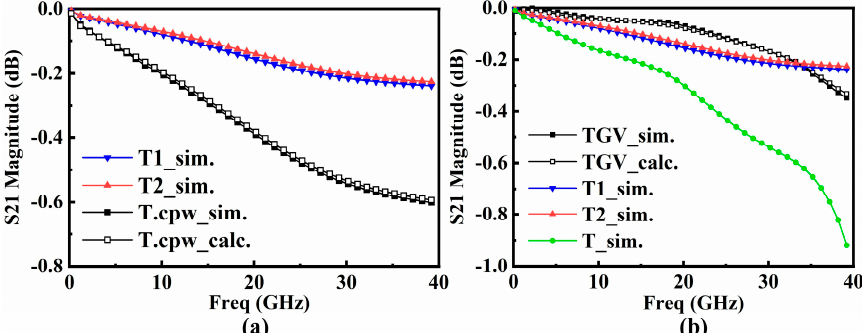
Figure 3. Verification of the validity of S-parameter extraction method from T-matrix. ( a ) Simulation model of the CPW series without TGVs, ( b ) The CPW series simulation model incorporating TGVs.